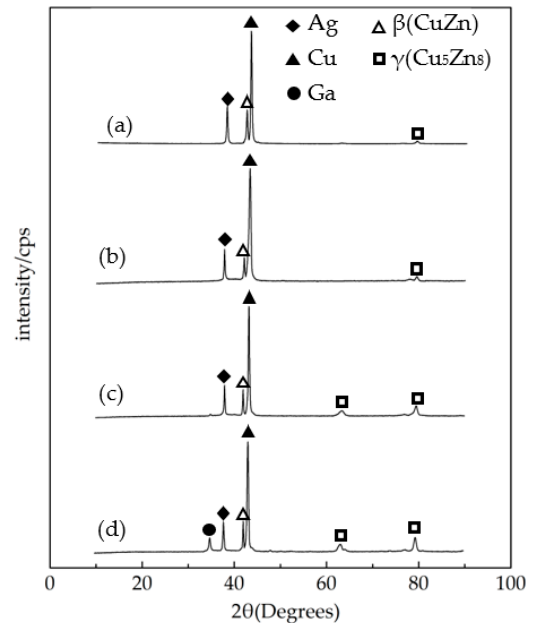
Figure 6. XRD patterns of the novel filler metals: ( a ) 12AgCuZnSn-2In-0.15Pr, ( b ) 12AgCuZnSn-2In-0.15Pr-1Ga, ( c ) 12AgCuZnSn-2In-0.15Pr-3Ga, and ( d ) 12AgCuZnSn-2In-0.15Pr-5Ga.